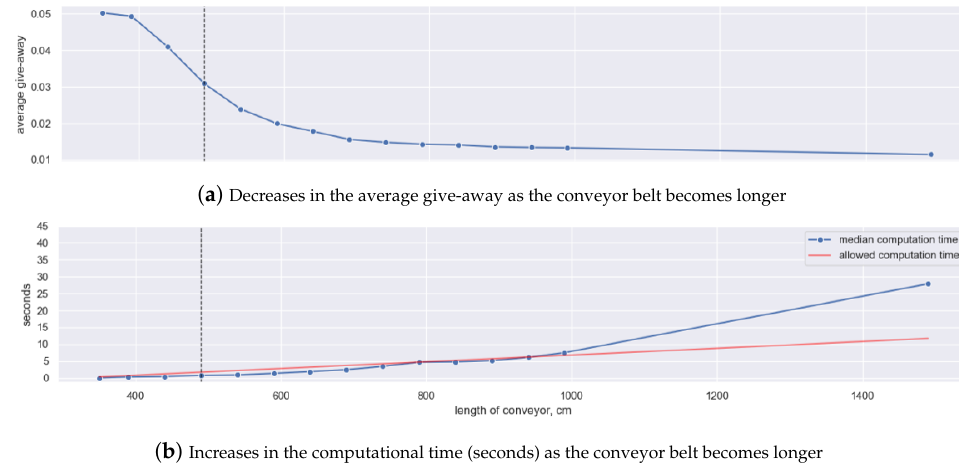
Figure 9. A snapshot of the implemented simulation